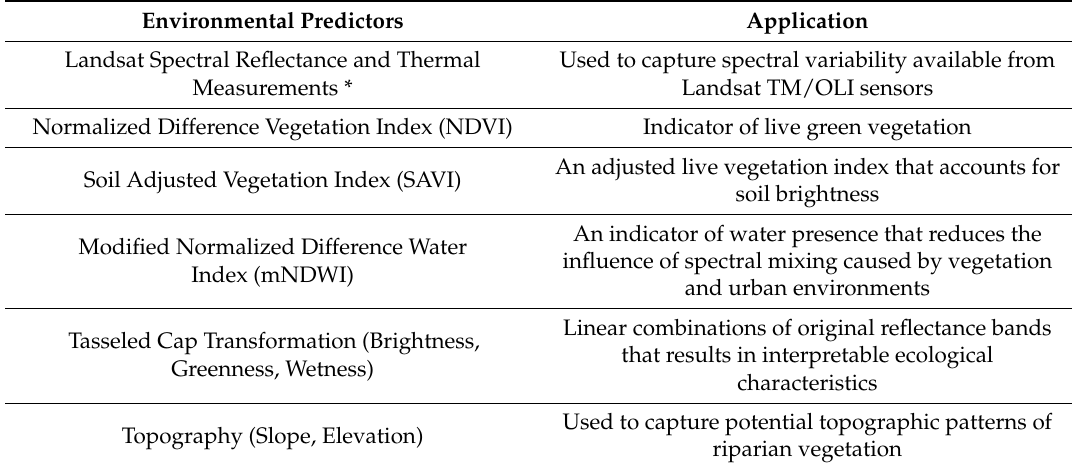
Table 1. The environmental predictors that were employed in each random forests classification model. Predictors were subsequently pared down through variable